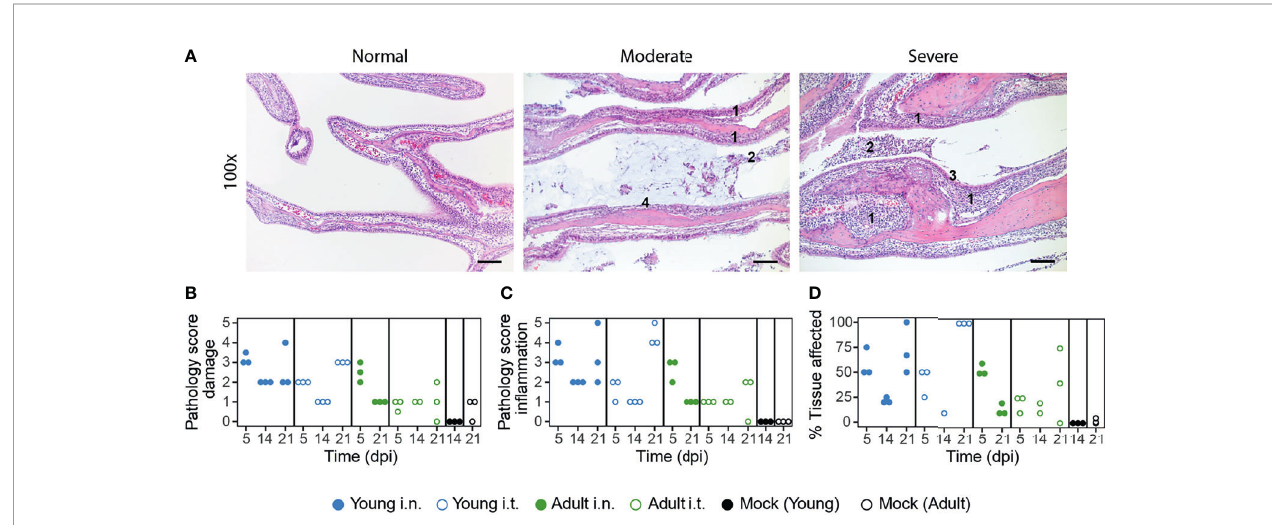
FIGURE 3 | SARS-CoV-2 infection induces more severe URT pathology in young ferrets. (A) Representative haematoxylin and eosin stained sections of normal, moderate (score 2) and severe (score 4) affected naso- and maxilloturbinates at 100x magni fi cation. SARS-CoV-2 infection induced in fi ltration of polymorphonuclear cells into the lamina propria and submucosa of the respiratory epithelium, resulting in thickened respiratory mucosa (indicated with ‘ 1 ’ ). This was accompanied by exudate containing mucus (moderate) and many polymorphonuclear cells, lymphocytes and some macrophages (2). The infection caused hyperplasia/hypertrophy of the epithelial cells (3) and sometimes the epithelial lining was absent (4). Images are from SARS-CoV-2 infected ferrets at 5 ( ‘ moderate and severe) or 21 dpi ( ‘ normal ’ ). Bars represent 100 m m. (B – D) Scoring by parameters related to epithelial damage (B) , in fl ammation (C) and percentage of tissue involved in pathologic changes (D) . The infection-induced pathology was scored on a scale of 0 – 5 based on the parameters described in the materials and methods. With exception of ‘ Adult i.t. ’ on 14 dpi (n = 2), all groups are n = 3 and each dot represents an